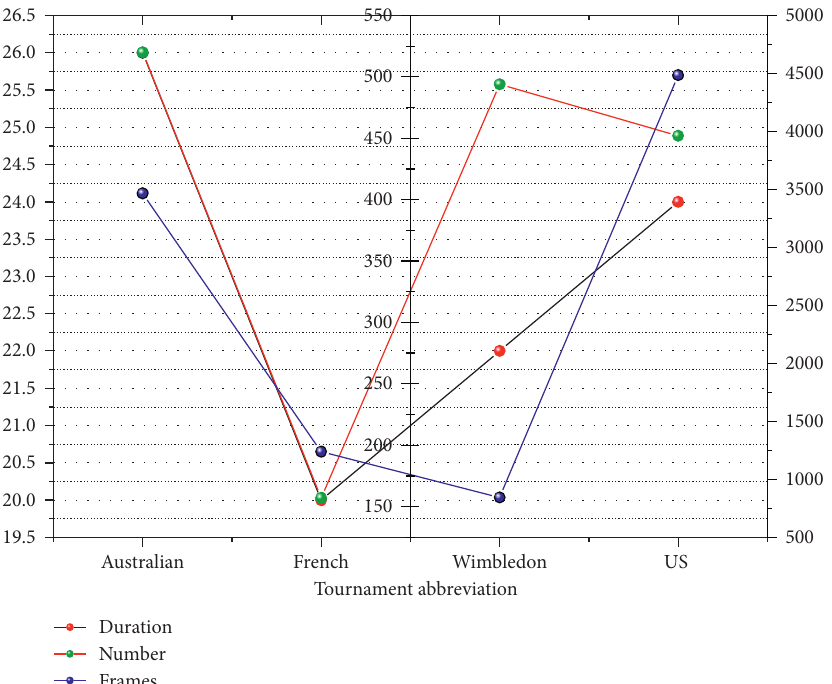
Figure 3: HD tennis match video